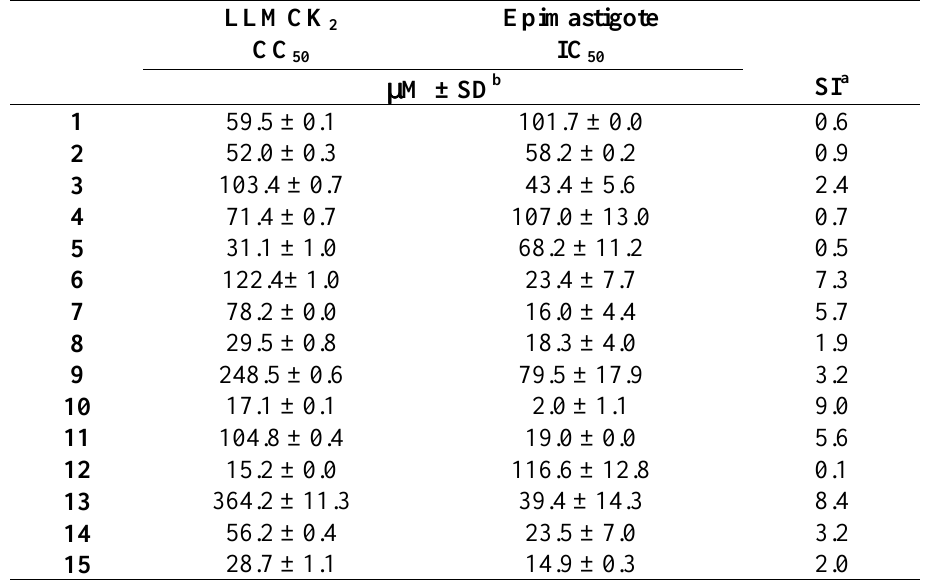
values for LLMCK Table 1. CC 50 Trypanosoma cruzi and theirs respective selectivity indexes